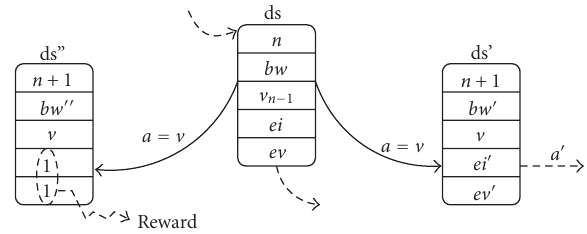
Figure 7: Simplified